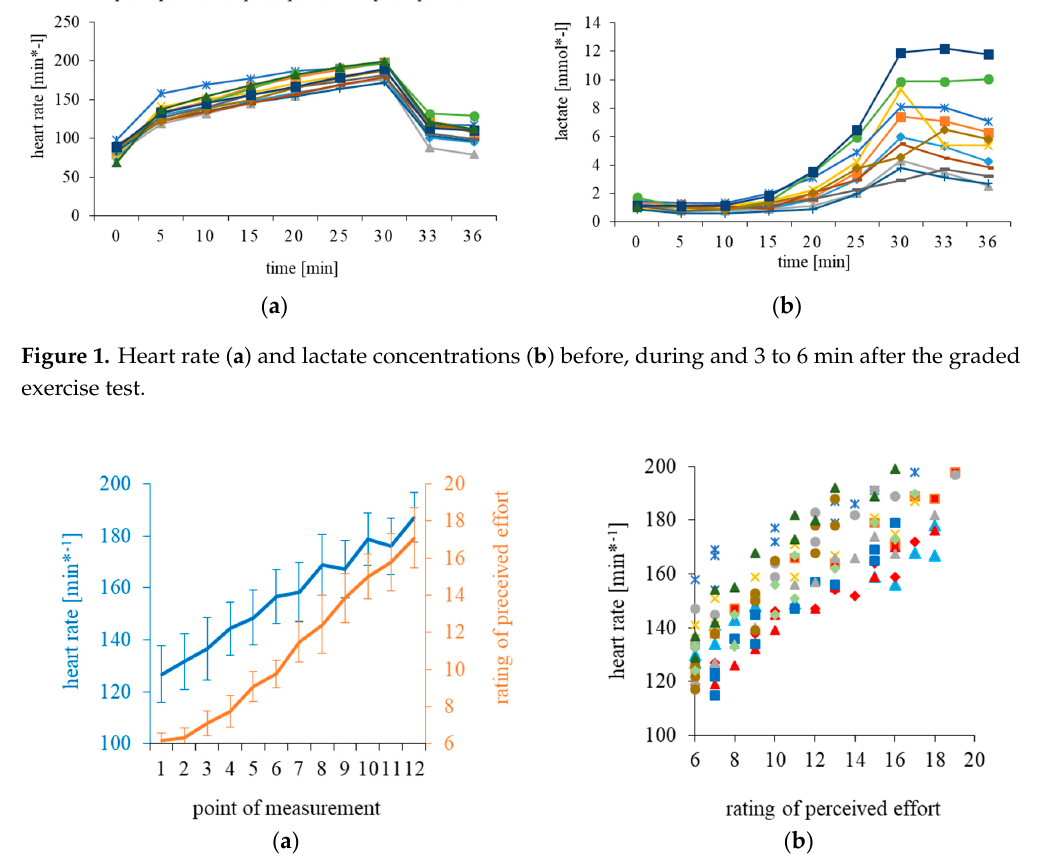
Figure 2. Inter-individual means and standard deviations for heart rate and the ratings of perceived effort ( a ). Individual data are shown in ( b ). e ff ort ( a ). Individual data are shown in ( b